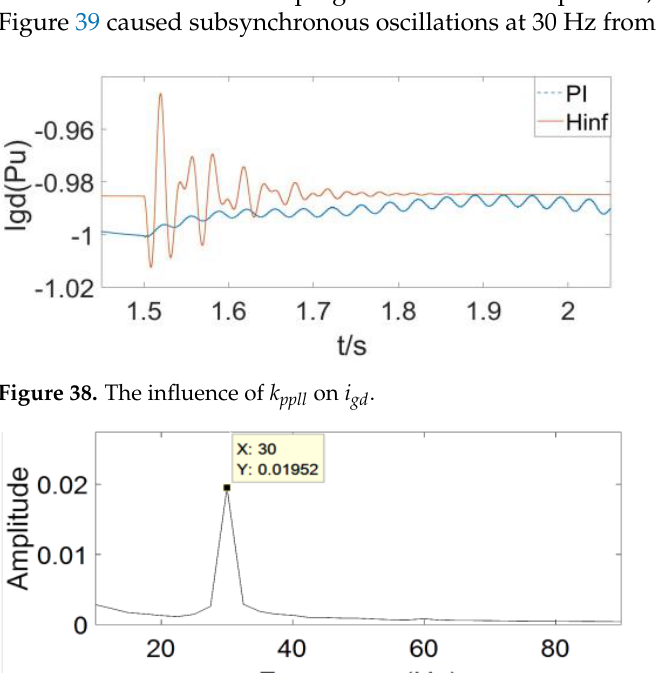
Figure 39. FFT analysis of i gd in PI controller (change k ppll ).